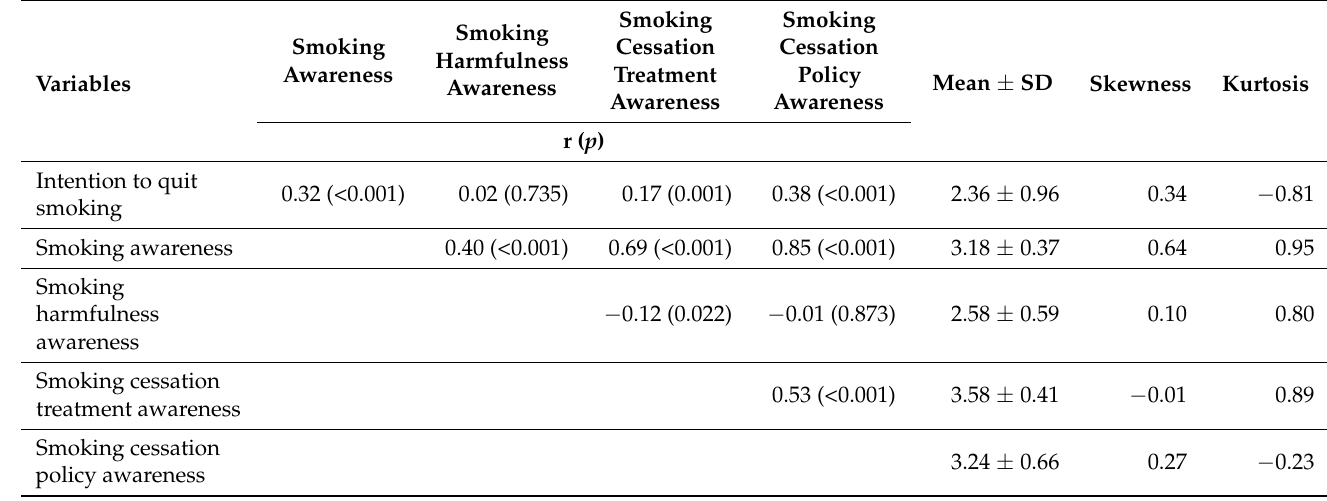
Table 2. Descriptive Statistics and Correlation of Research Variables ( n =